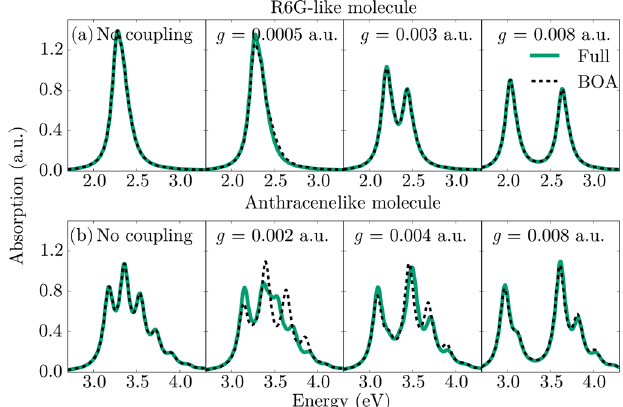
FIG. 4. Absorption cross sections of a single molecule, calcu- lated using the full Hamiltonian without approximation (solid green lines) and within the BOA (dashed black lines). Results are shown for the (a) R6G-like and (b) anthracene-like model molecules, for several values of the coupling strength g